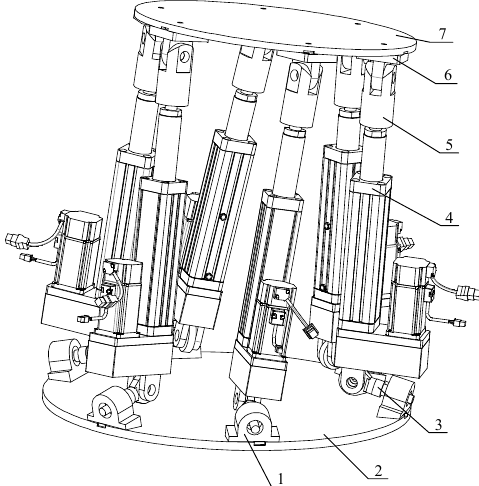
Figure 5. Three-dimensional model of 6-DOF platform. (1, Bearing pedestal; 2, Lower platform; 3, Journal stirrup; 4, Electric cylinder; 5, Rotating double ear support; 6, Fixed single ear; 7, Upper platform).